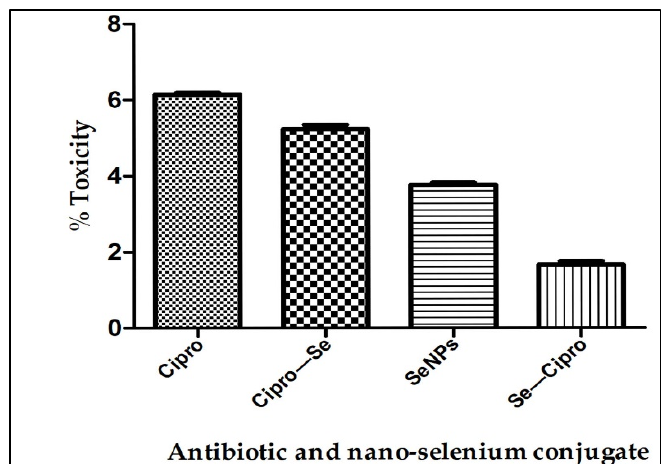
Figure 6. Graphical representation of the percentage toxicity of the different treatments given to the Acanthamoeba cells. Acanthamoeba